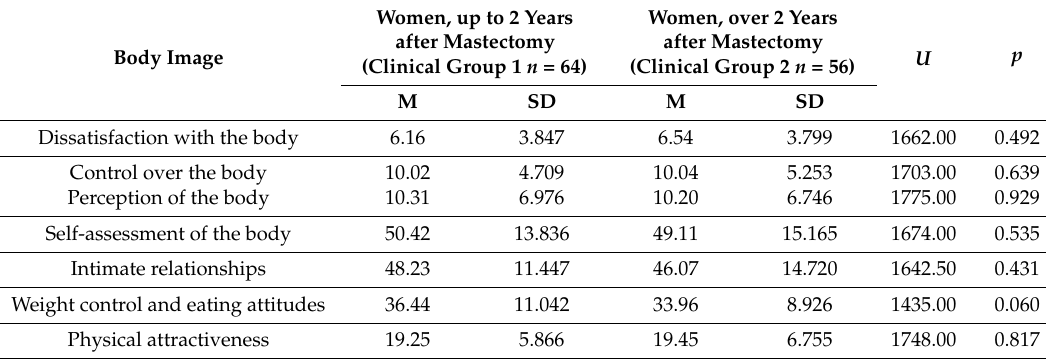
Table 3. The comparison of raw results (Mann-Whitney U test) regarding indicators of the dependent variable ‘body image’ between clinical group 1, and (clinical group